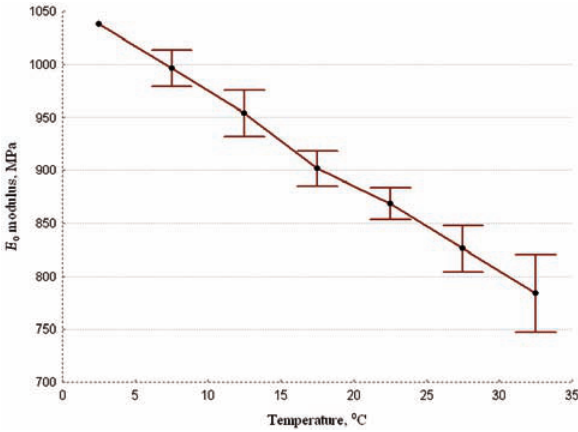
Fig. 5. Reliability intervals of E values measured during 0 research in the asphalt layer of road pavement structure: –mean; – mean ±0.95 confidence